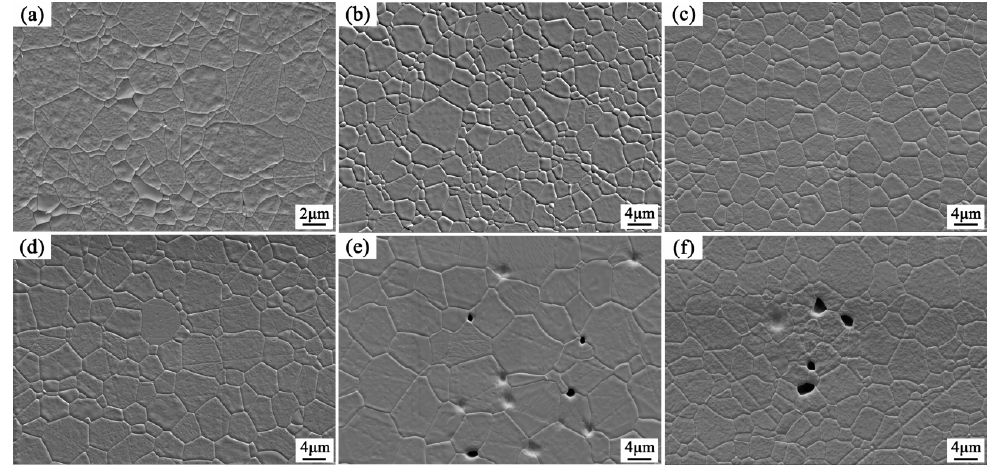
Fig. 13 Thermally etched surfaces of La 2– x Gd x Hf 2 O 7 transparent ceramics: (a) x = 0; (b) x = 0.4; (c) x = 0.8; (d) x = 1.2; (e) x = 1.6; and (f) x = 2.0. Reproduced with permission from Ref. [44], © Elsevier B.V.